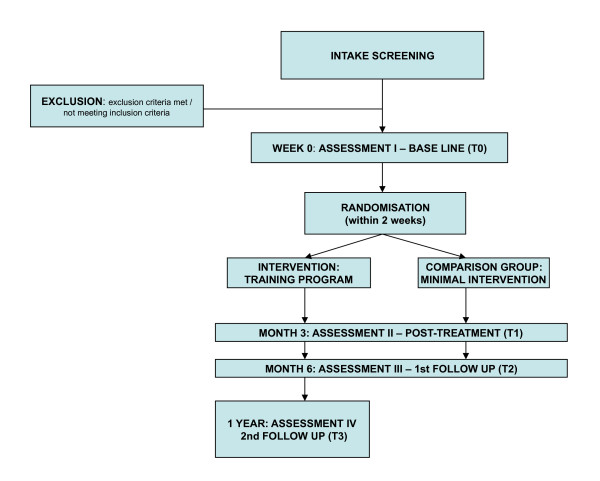
Research procedure.